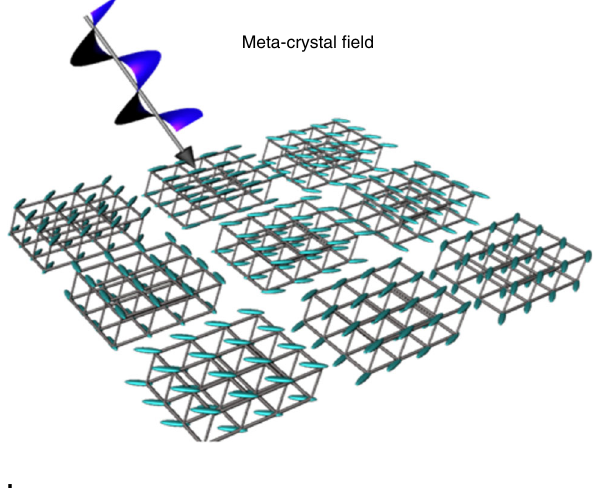
Fig. 1a. On the length scale of the Eu 3 + co-ordination environment, all the oxygen atoms would be polarised in the same direction. The induced polarisation breaks mirror symmetry, unless the incident light is orthogonal to a mirror plane of the co-ordination